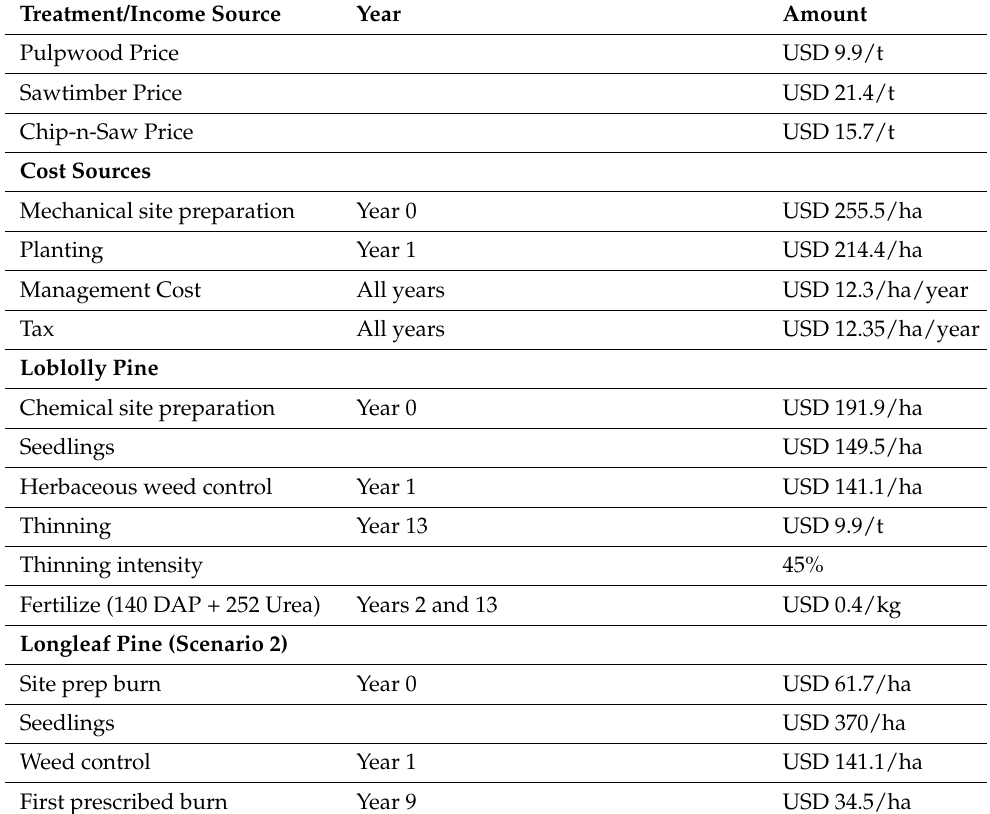
Table 2. Selected incomes (USD), costs (USD), and silvicultural treatments for estimating the optimal rotation age of a hectare of loblolly and longleaf pines in South Georgia, United States. The prices of timber products and silvicultural management costs were obtained from TMS (2019) [30] and Maggard and Barlow (2018) [38], respectively. Fertilization volume and applications are as per the productivity of sandy soils in the Lower Coastal Plain [36]. Longleaf pine stands that are suitable for raking pine straw are commonly raked starting canopy closure until the first thinning [36]. Hence, pine straw raking started from year eight until the first thinning age for longleaf pine. We used Gonzalez-Benecke et al. (2015) [39] to estimate annual needle fall and pine straw yields. We did not rake pine straw for the years when the longleaf pine stand was burned